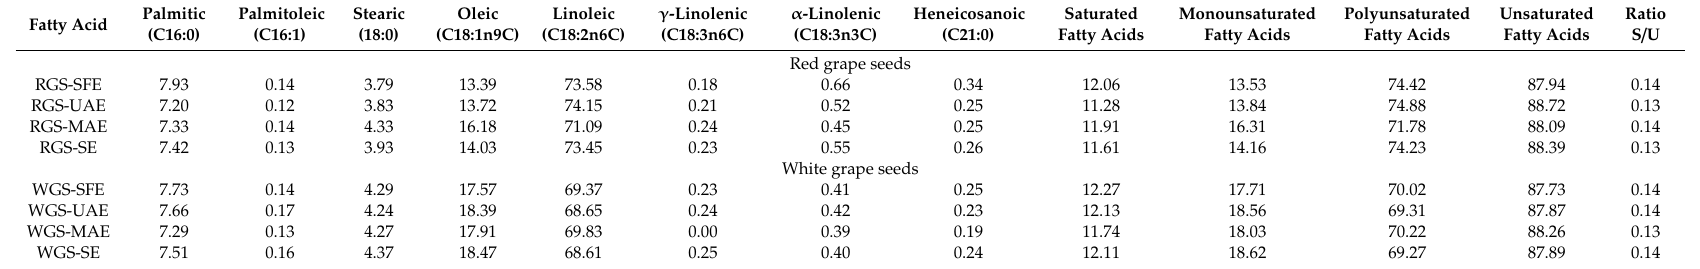
Table 2. Relative content (%) of fatty acids in red and white grape seed oils obtained by di ff erent extraction